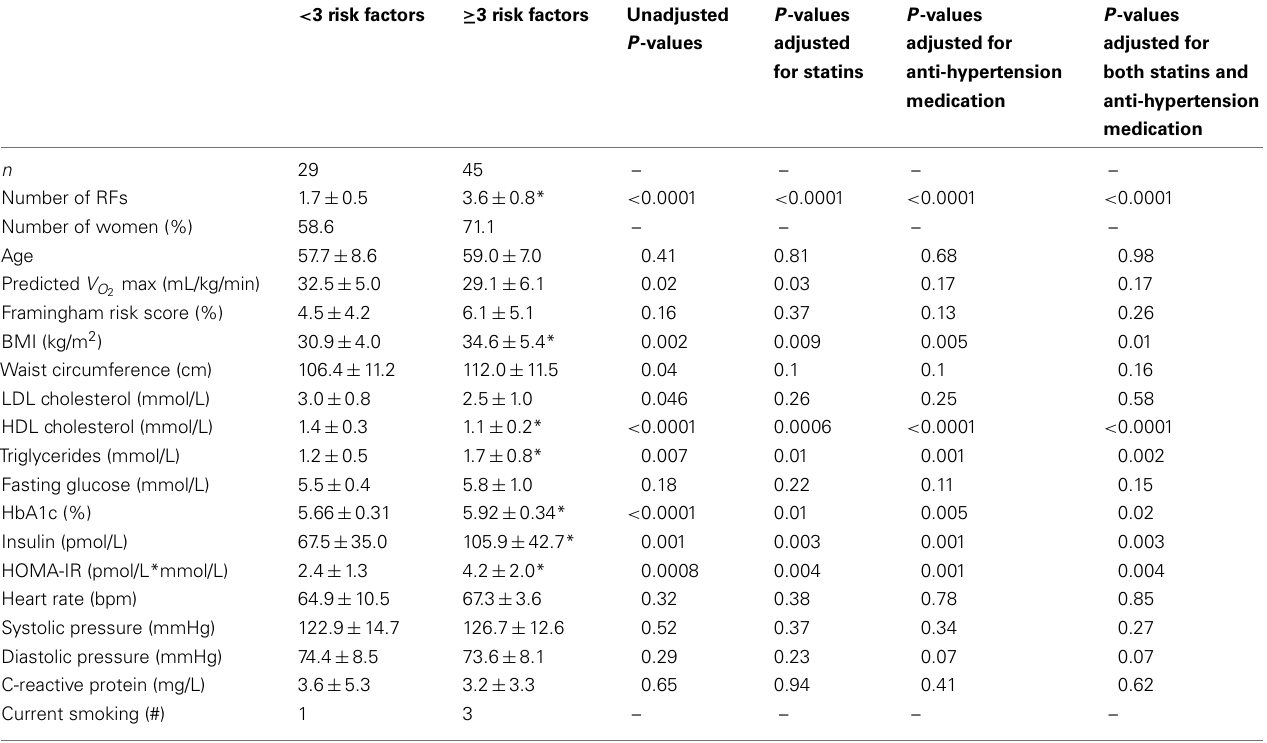
< 3 risk factors ≥ 3 risk factors Unadjusted